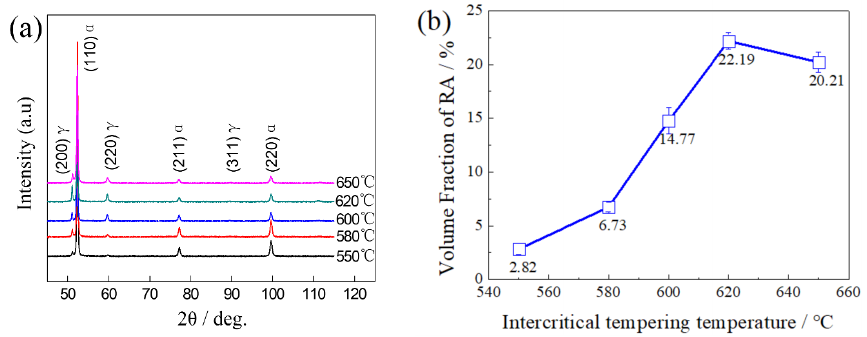
Figure 5. ( a ) XRD line spectra patterns, and ( b ) the tested volume fraction of RA.